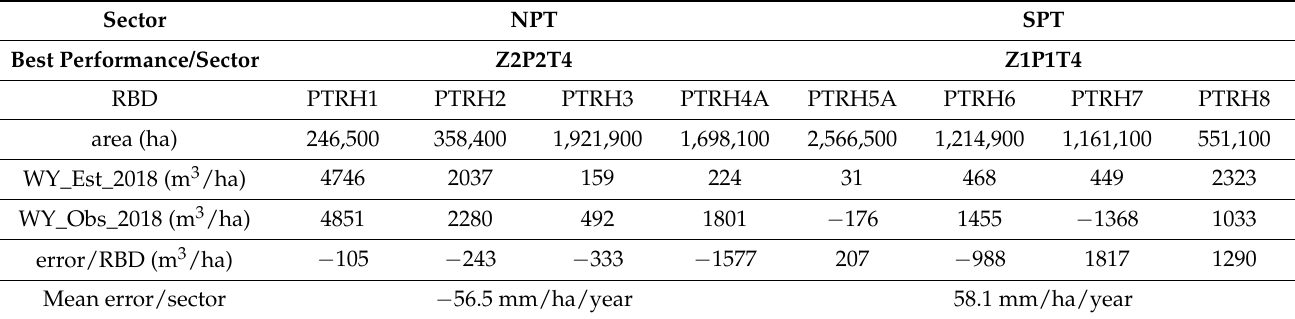
Table 4. Mean estimated WY, observed values and the error in the estimations.